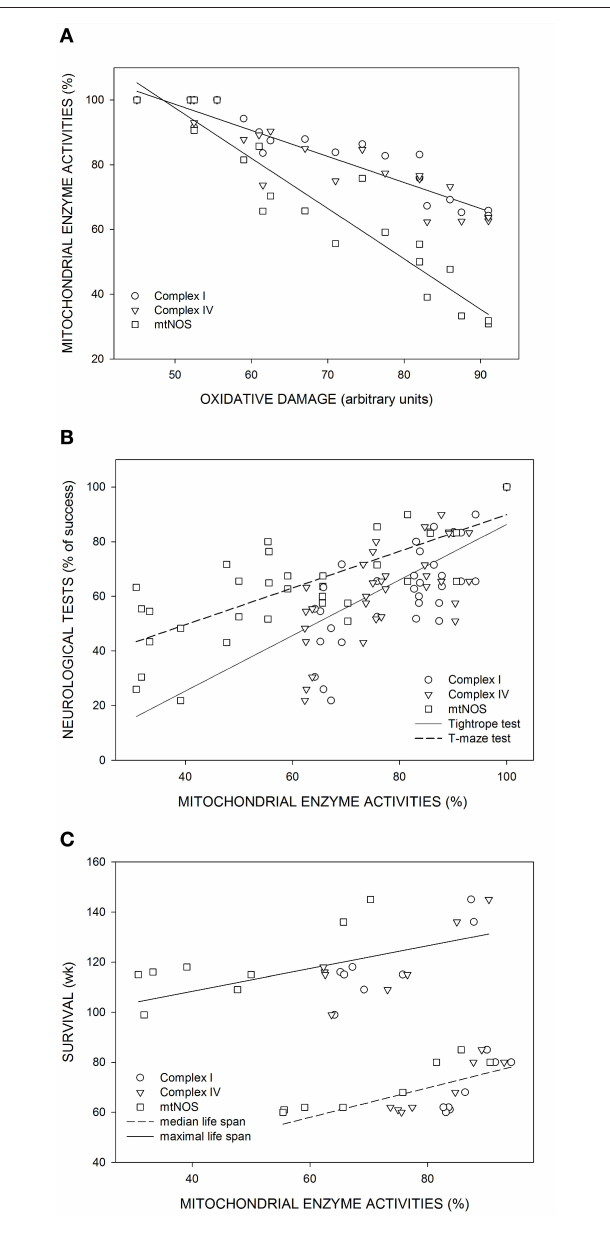
Figure 1 | Statistical correlations involving: (A) mitochondrial enzyme activities (complexes i and iV and mtNOS) and mitochondrial oxidative damage ( r 2 = 0.84; p < 0.01 for complexes i and iV; r 2 = 0.90; p < 0.01 for mtNOS); (B) enzyme activities and neurological tests (tightrope, r 2 = 0.62; p < 0.001; T-maze, r 2 = 0.56; p < 0.05) and enzyme activities and median ( r 2 = 0.46; p < 0.05), and maximal ( r 2 = 0.31; p < 0.01), life spans (C) in male mice. Data from (Navarro et al., 2002, 2004, 2005a, 2007). For the neurological assays, individual mice were subjected every 2 weeks to the tightrope and the T-maze tests (Navarro et al., 2002). For the tightrope test, mice were placed hanging from their anterior legs in the middle of a 60-cm tightrope and the test was considered successful when mice reached the column at the end of the rope in less of 30 s. For the T-maze test, mice were challenged in a T-shaped maze of 50 cm arms and the test was considered successful when mice moved toward the T-intersection in less than 30 s. Modified from Boveris and Navarro